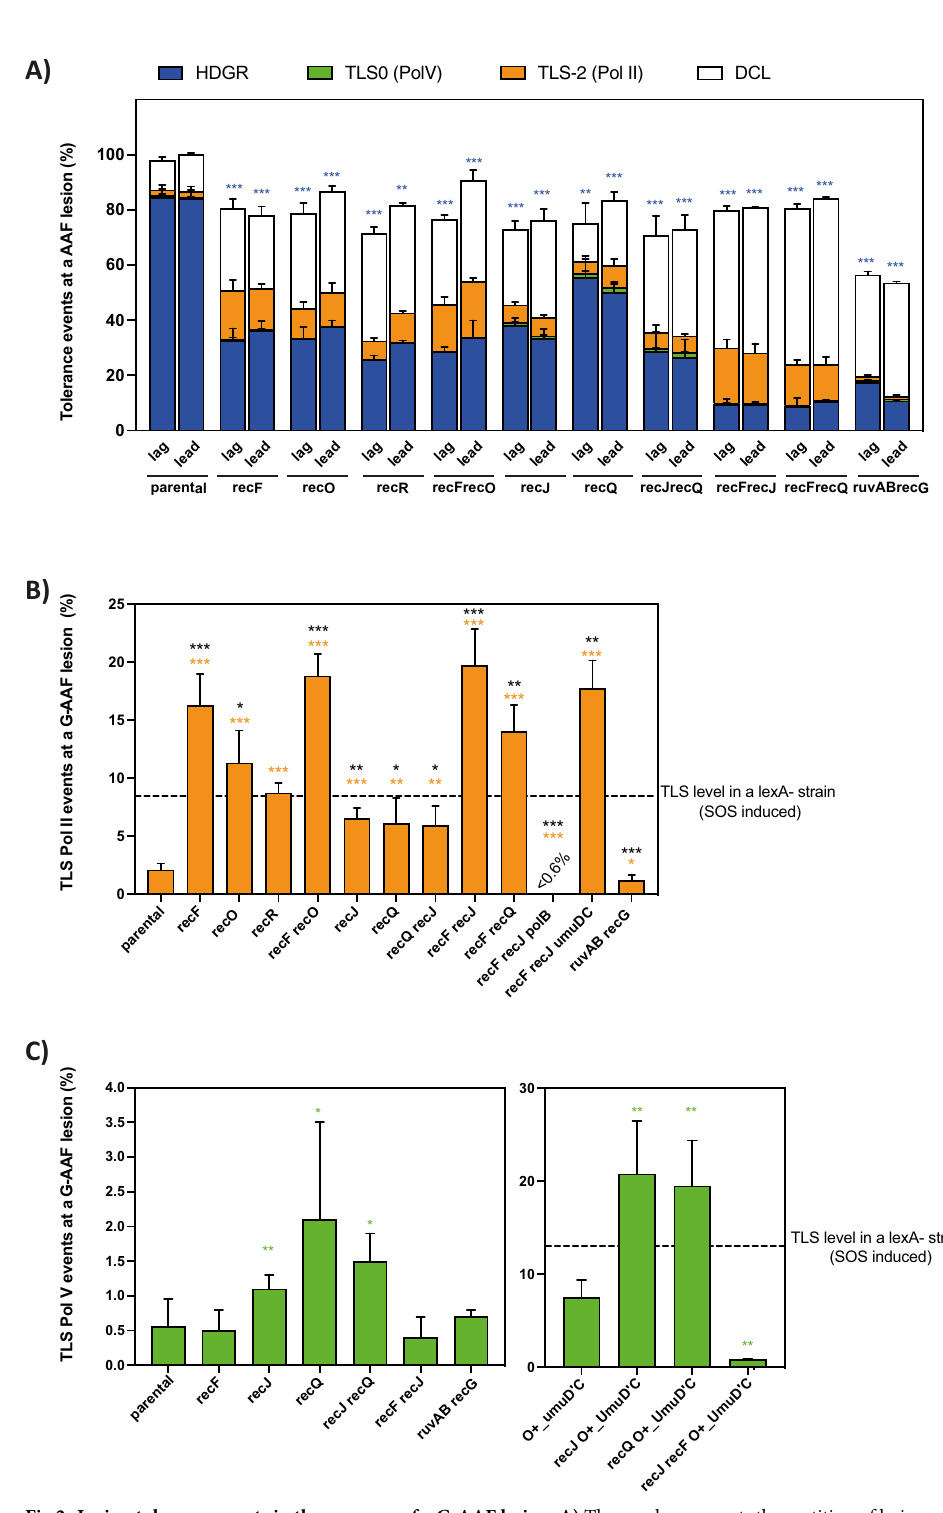
Fig 2. Lesion tolerance events in the presence of a G-AAF lesion. A) The graph represents the partition of lesion tolerance pathways ( i . e . HDGR, TLS and DCL) and the cell survival in the presence of a G-AAF lesion for the strains affected in the presynaptic and postsynaptic phase of the RecF pathway (for more details see Material and Methods section). The lesion was inserted either in the lagging (lag) or in the leading (lead) strand compared to the replication fork direction, however no statistically significant differences were found between leading and lagging strands.